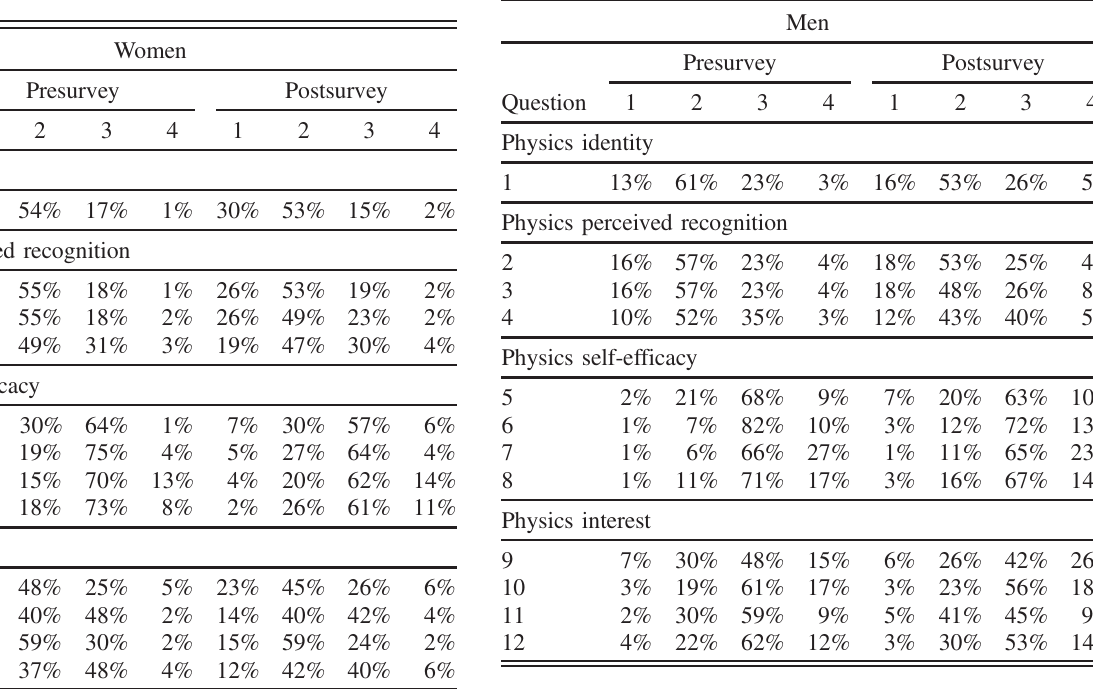
TABLE XI. Percentages of 148 men in physics 2 who answered each question in physics 2 by the options they selected with 1 being the low value (NO! and strongly disagree) and 4 being the high values (YES! and strongly agree). The rating scale for the self-efficacy and interest questions was NO!, no, yes, YES! while the rating scale for the physics identity and perceived recognition questions was strongly disagree, disagree, agree, strongly